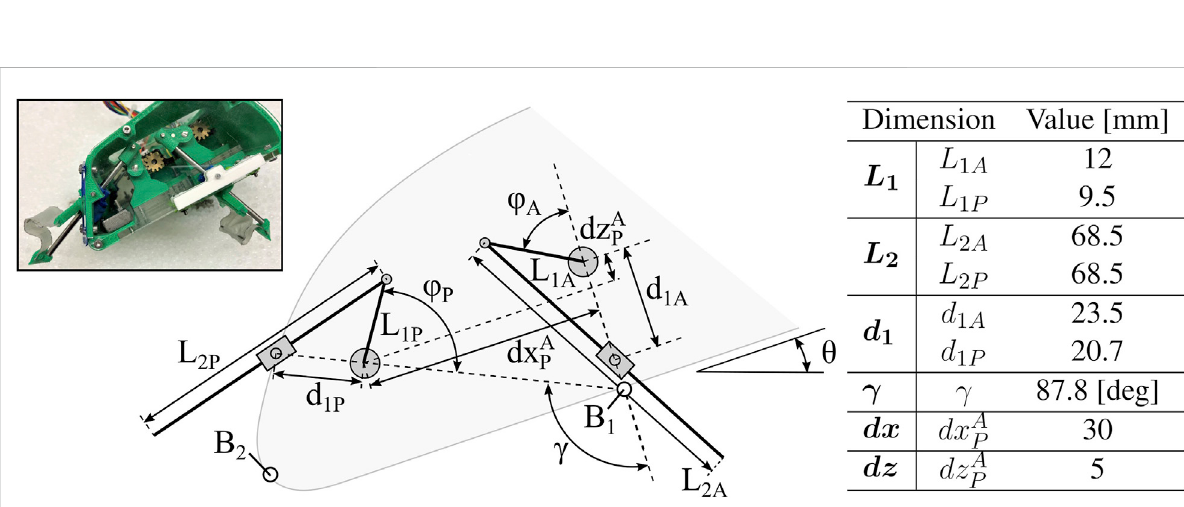
FIGURE 4 RobotParameterDe fi nitions.Geometricparametersofvariousrobotcomponents,includinglinkageandleglengths,distancesbetweenpivots, and leg and body orientation